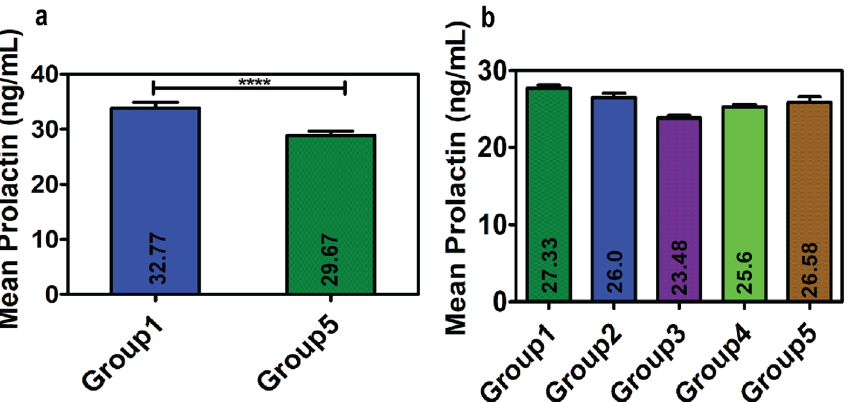
Figure 3. Graphical representation of the results between 20 and 40 ng/mL for the different groups in ( a ) Phase 1 and ( b ) Phase 2 study. [Results are expressed as mean ± SD; statistical significance denoted by ‘****’ corresponds to p <